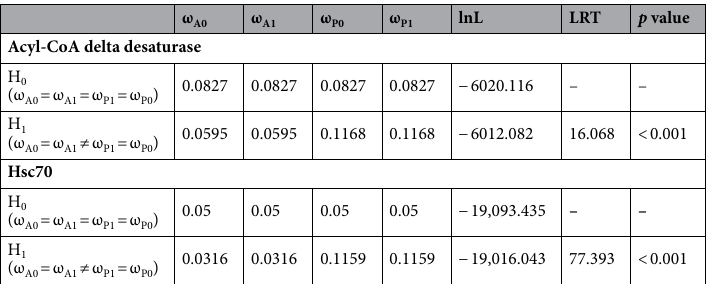
Table 2. Selective pressures in acyl-CoA delta desaturase and Hsc70. The null hypothesis (H0) and the alternative hypothesis (H1) were defined as the case where d N / d S (ω) values are identical in P. steinenii - specific and orthologous gene families and when ω differs between P. steinenii -specific and orthologous gene families, respectively. The ω (ω A0 , ω A1 , ω P1 , and ω P0 ) indicates the d N / d S ratio for the corresponding branch (Supplementary Fig. 3). All p values were calculated using a log-likelihood (lnL) values and likelihood ratio test (LRT) and adjusted false discovery rate (FDR).